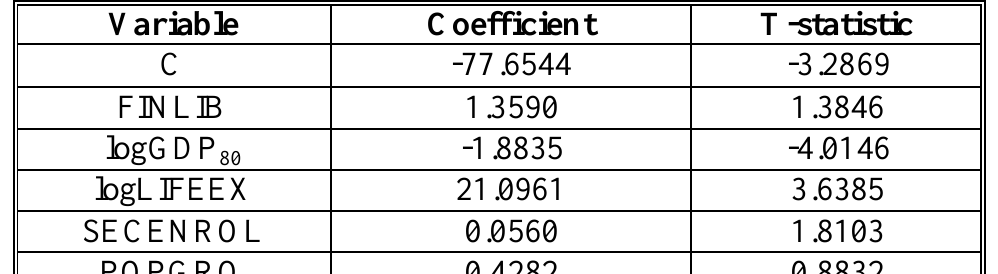
Financial liberalisation and growth